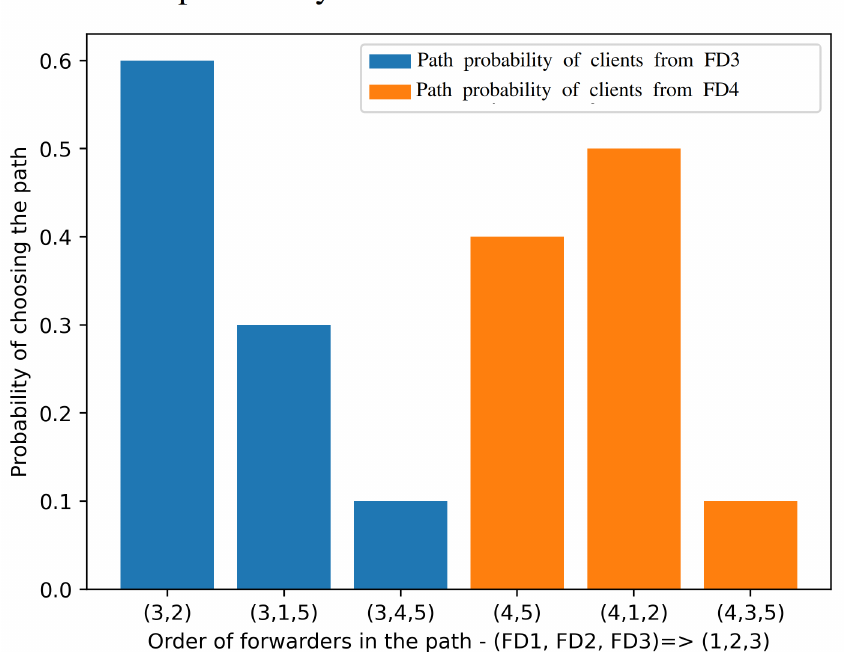
Figure 9. Measured relative frequency with which the optimization algorithm chooses the different network paths in Figure